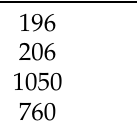
Table 2. Low strength standard concrete mixture in kg/m 3